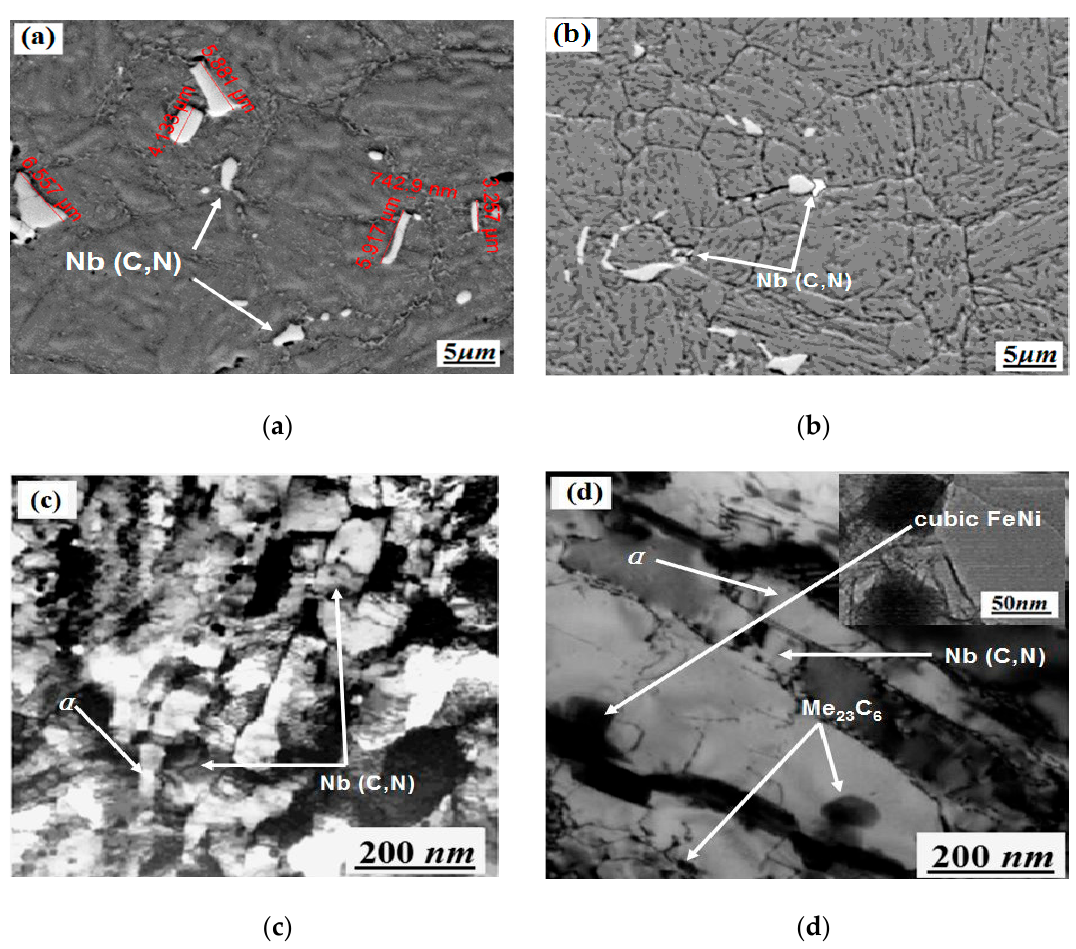
Figure 6. SEM analysis of X6CrNiMoVNb11-2 steel before and after heat treatment: ( a ) SEM of the initial as-rolled microstructure before heat treatment; ( b ) SEM after quenching (at 1040 °C, oil cooling) and tempering (at 650 °C, oil cooling) processes; ( c ) TEM of the initial as-rolled microstructure before heat treatment; ( d ) TEM after quenching (at 1040 °C, oil cooling) and tempering (at 650 °C, oil cooling) processes.